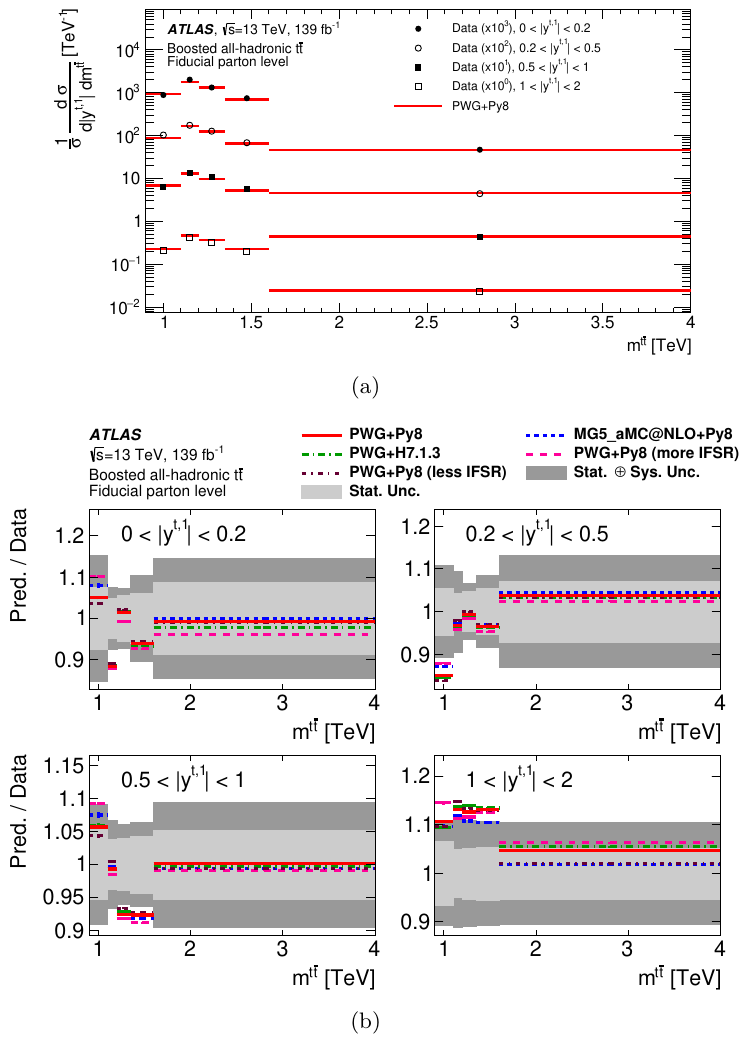
Figure 49 . (a) Normalized parton-level fiducial phase-space double-differential cross-sections as a function of the absolute value of the rapidity of the leading top-quark and the mass of the t ¯ t system, compared with the Powheg+Pythia 8 calculation. Data points are placed at the centre of each bin and the Powheg+Pythia 8 calculation is indicated by solid lines. The measurement and the prediction are normalized by the factors shown in parentheses to aid visibility. (b) The ratios of various MC calculations to the normalized parton-level fiducial phase-space differential cross-sections. The dark and light grey bands indicate the total uncertainty and the statistical uncertainty, respectively, of the data in each